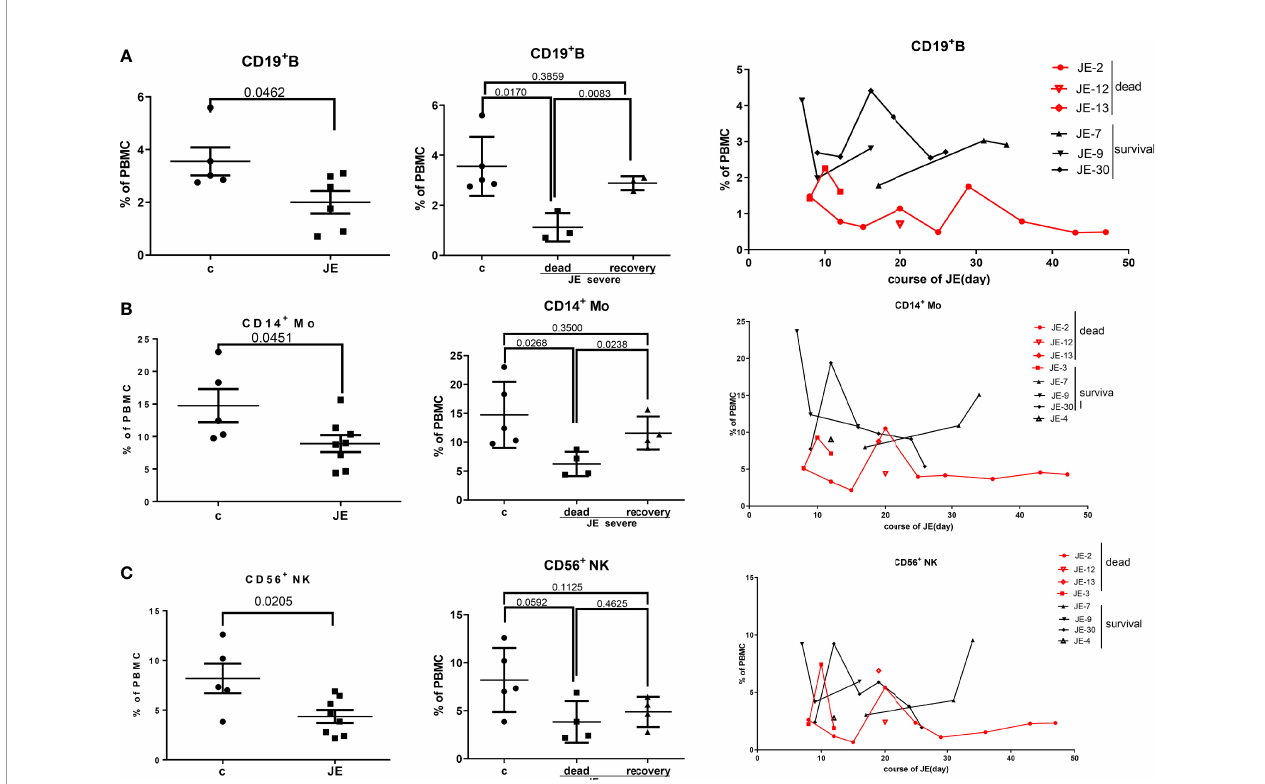
FIGURE 7 | The number of B cells, monocytes, and NK cells decreased signi fi cantly in JE patients with fatal progression. The PBMCs from severe JE patients with different outcomes were collected at several time points. The percentages ofCD19 + B cells, CD14 + monocytes, and CD56 + NK cells were detectedby fl ow cytometry and analyzed usingFlowJo Software v7.6. The data in the severe patients were the mean percentage from several time points of each patient. (A) The percentage, comparison, anddynamic development of CD19 + B cells inthe PBMCs fromthe healthycontrolsand severe JEpatients. (B) The percentage, comparisonand dynamicdevelopment of CD14 + monocytes inthe PBMCs fromthe healthycontrolsand severe JEpatients. (C) The percentage, comparison, and dynamicdevelopment of CD56 + NK cells inthe PBMCs from the healthy controlsandsevere